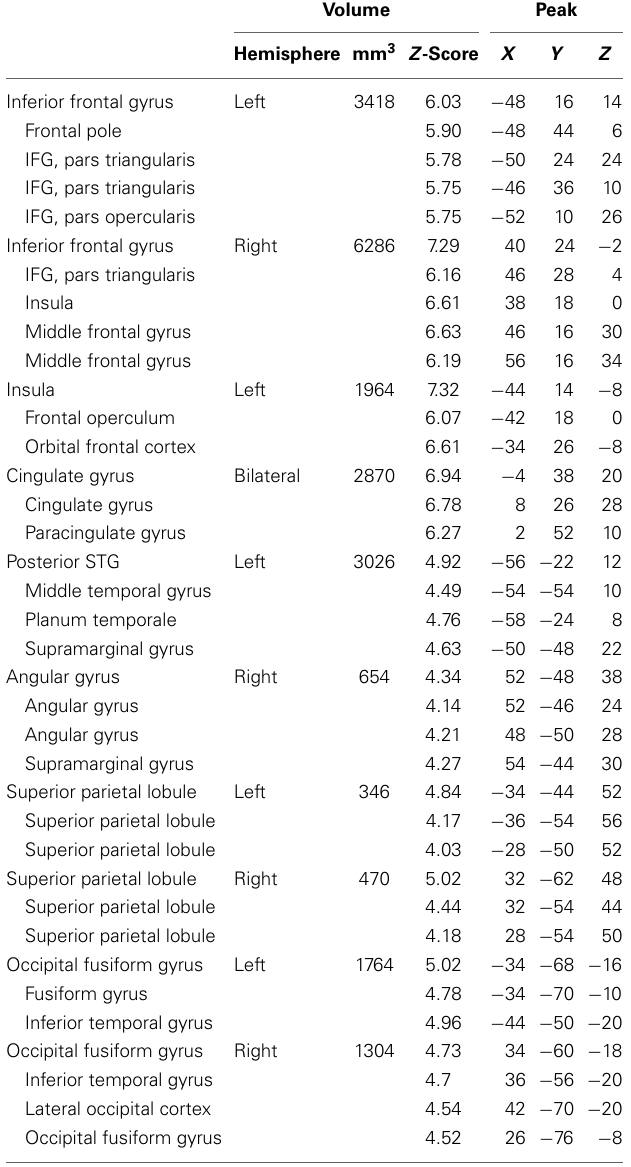
Table 4 | Positive correlations to naming latency—regions with sub-peaks.